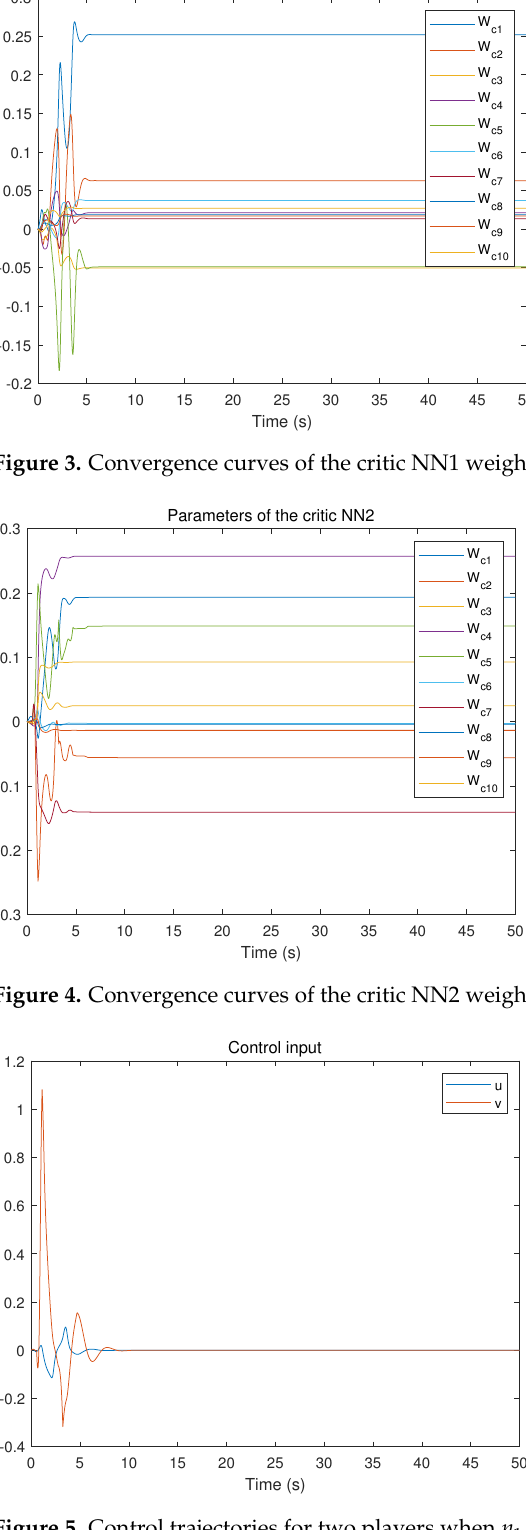
Figure 5. Control trajectories for two players when η 1 = 1 and η 2 = −